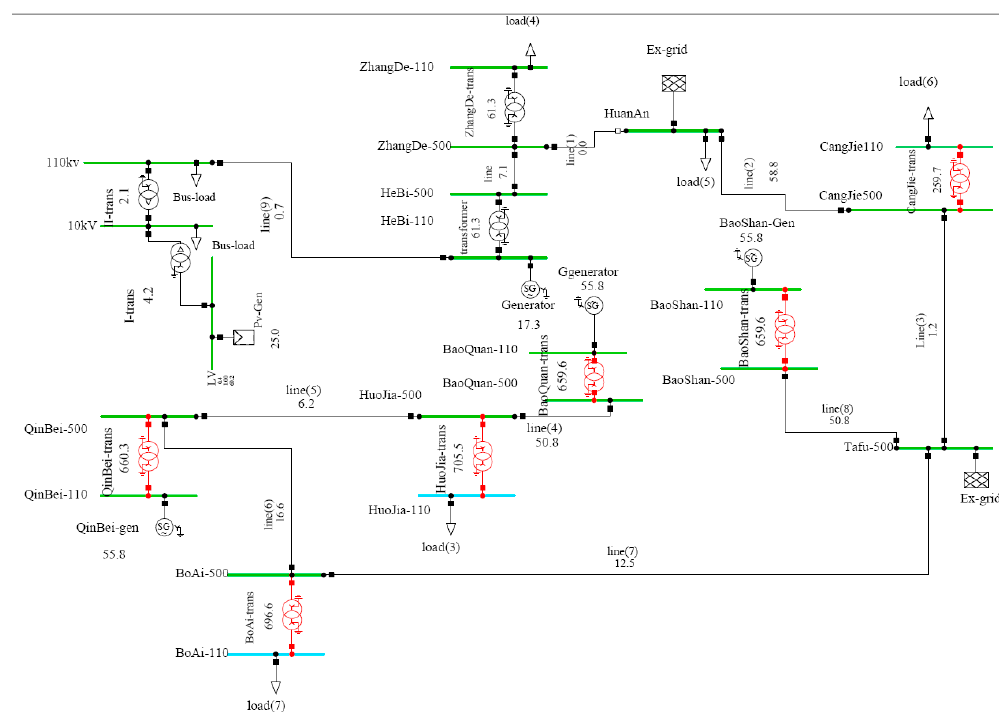
Figure 2. Yubei photovoltaic power generation grid connection diagram.